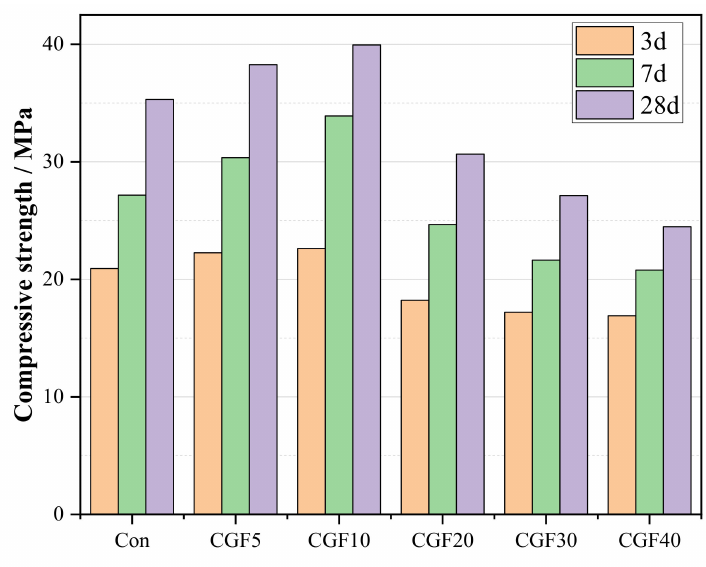
Figure 6. Compressive strength development of